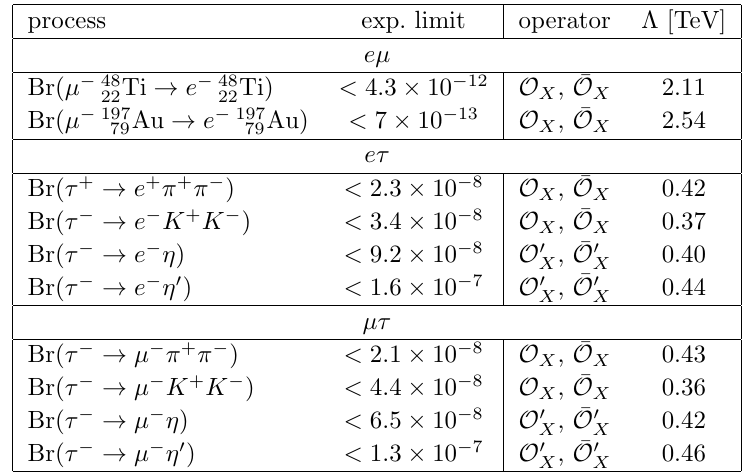
Table 3 . Constraints on the couplings from low-energy precision experiments. The limits are taken from ref.